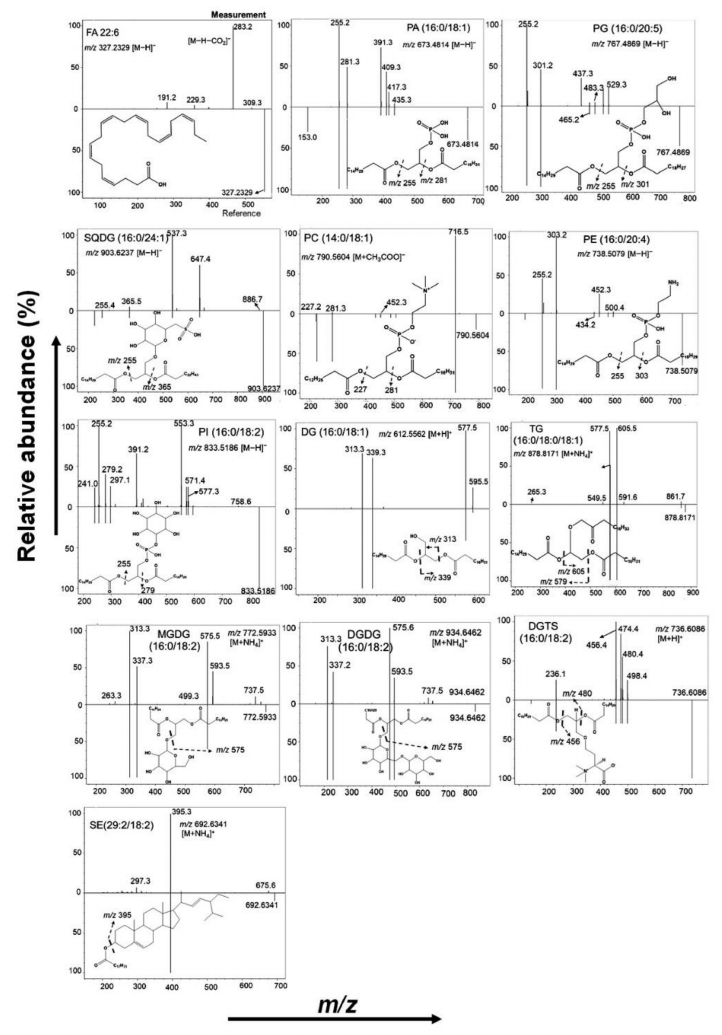
Figure 1. MS/MS spectra of representative lipid molecular species characterized in the